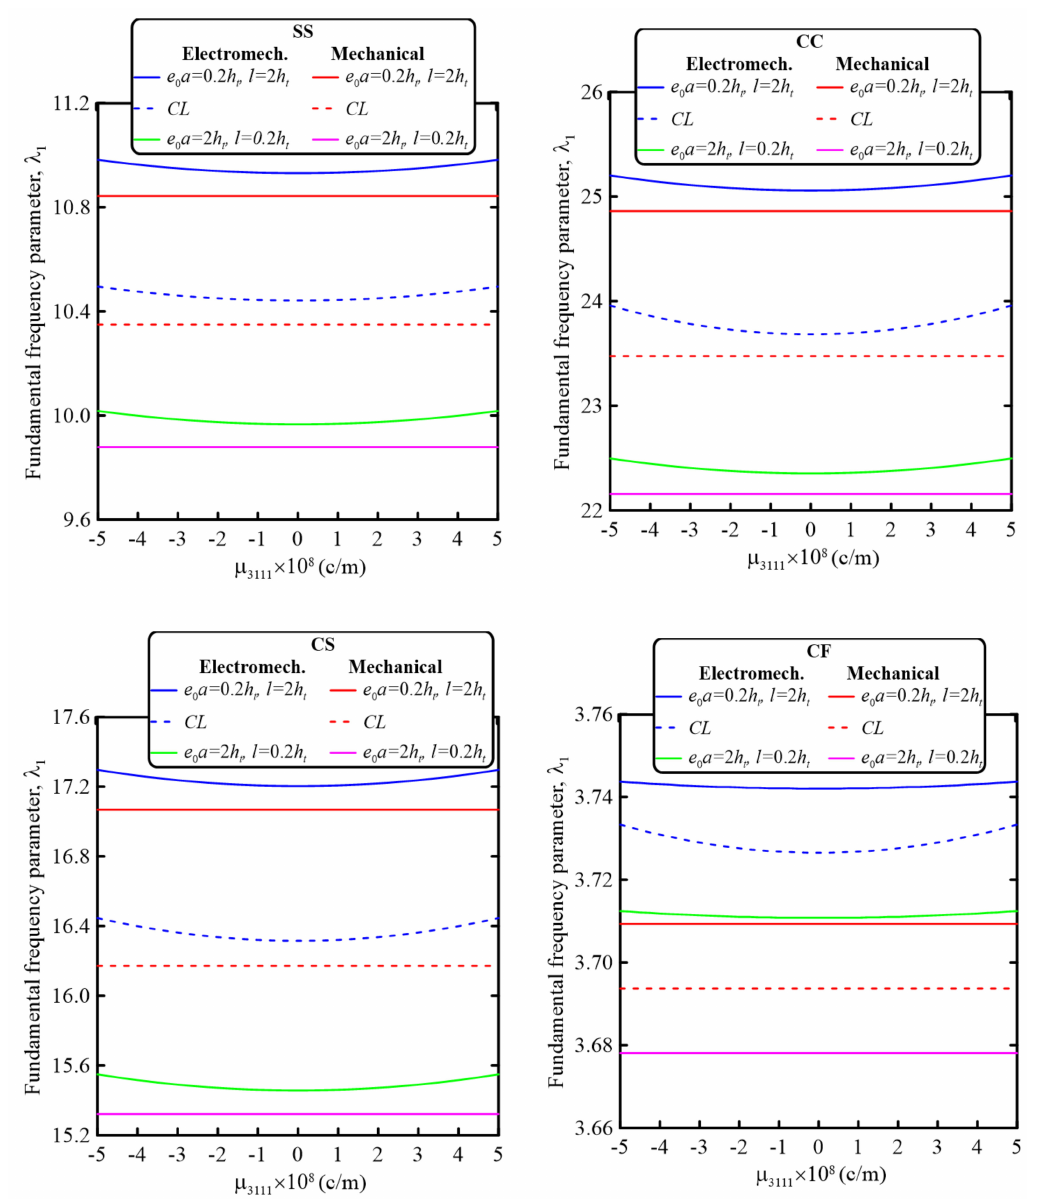
Figure 8. Variation of the fundamental frequency parameter λ 1 with the electric field–strain gradient coupling coefficient µ 3111 for nonclassical and classical electromechanical and mechanical analyses of piezoelectric sandwich nanobeams at different values of strain gradient and nonlocal param- eters for different beam boundary conditions at α = 0.5 and beam aspect ratio L / h t = 20 (N =